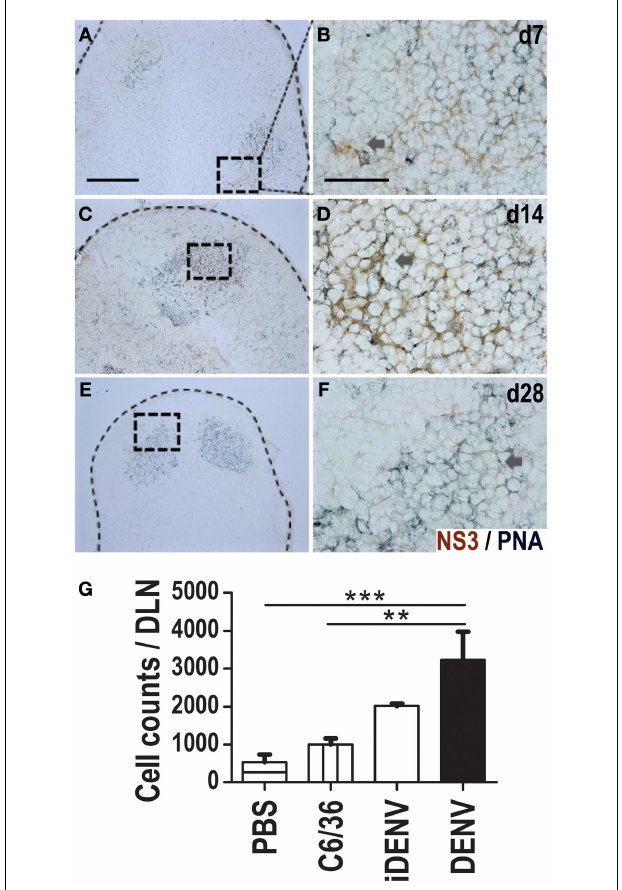
FIGURE 6 | NS3 viral protein is present inside GCs in DLNs . Viral NS3 protein was identified in situ (DAB, brown color) in a double staining with GCs (PNA, blue-gray color) in DLN at day 7 (A,B) , 14 (C,D) , and 28 (E,F) post-DENV-inoculation. Positive cells were found inside GCs. For each time point, right images [60 × , scale bar 40 µ m; (B,D,F) ] are derived from left indicated squares [10 × , scale bar 200 µ m; (A,C,E) ]. Data are representative from three independent experiments. Dotted lines indicate the limits of LNs. (G) NS3-specific GC B cells at day 14 post-inoculation by flow cytometry using multimers of NS3 viral protein. Data shown are pooled from two independent experiments, represent the mean ± SEM, and were analyzed with two-way ANOVA with the Bonferroni post-test. ** P < 0.01, *** P < 0.001. Mice were inoculated at day 0 and boosted at day